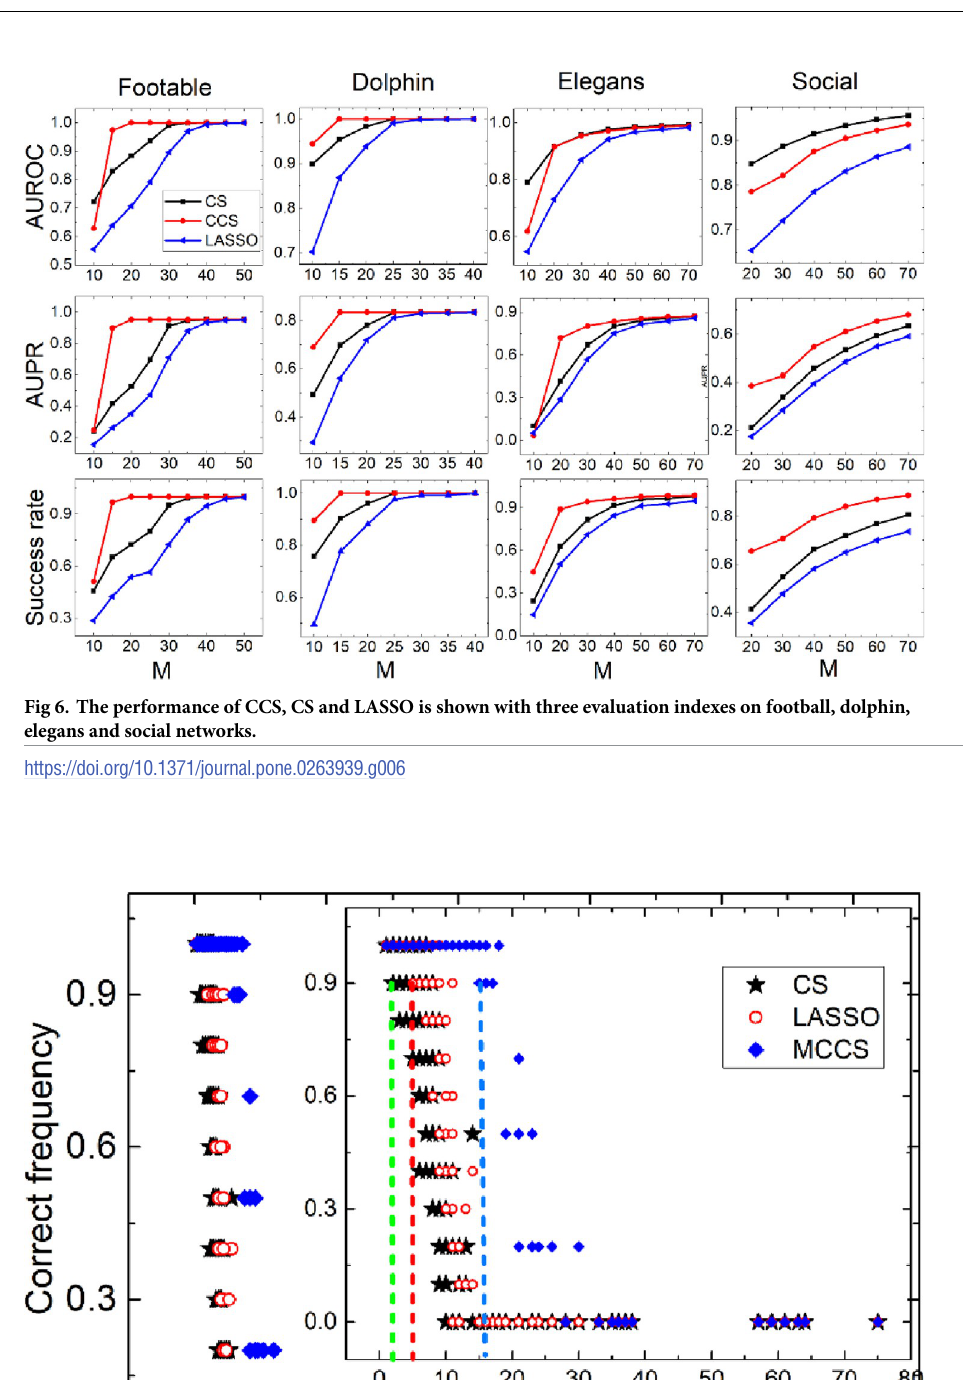
PLOS ONE | https://doi.org/10.1371/journal.pone.0263939 February 11,